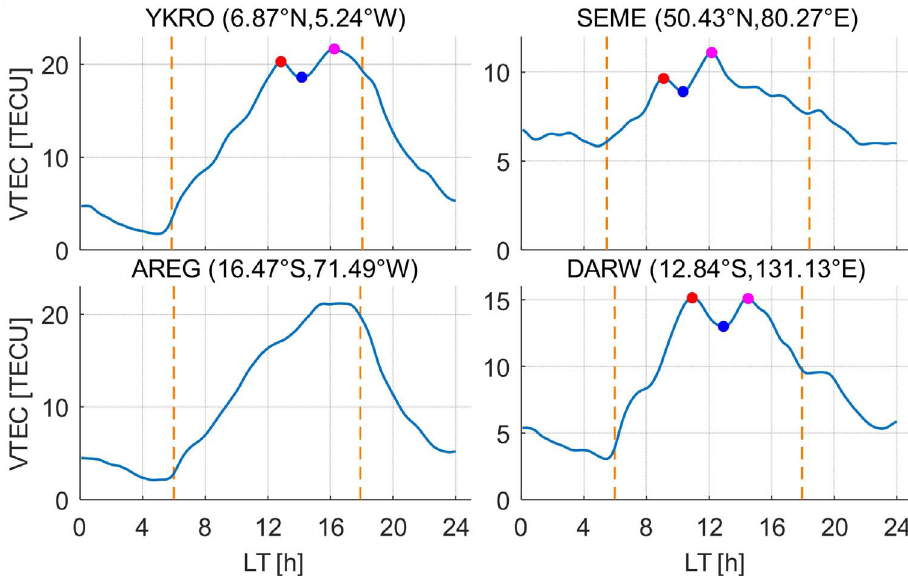
Figure 2. Diurnal VTEC variation shows a DDM phenomenon and no DDM phenomenon in DOY 254 in 2020. The coordinates in the fi gure are the geographic coordinates of each station. Peak1, valley, and peak2 of the DDMs are marked in red, blue, and magenta, respectively. The orange vertical dotted lines represent the local sunrise and sunset time.